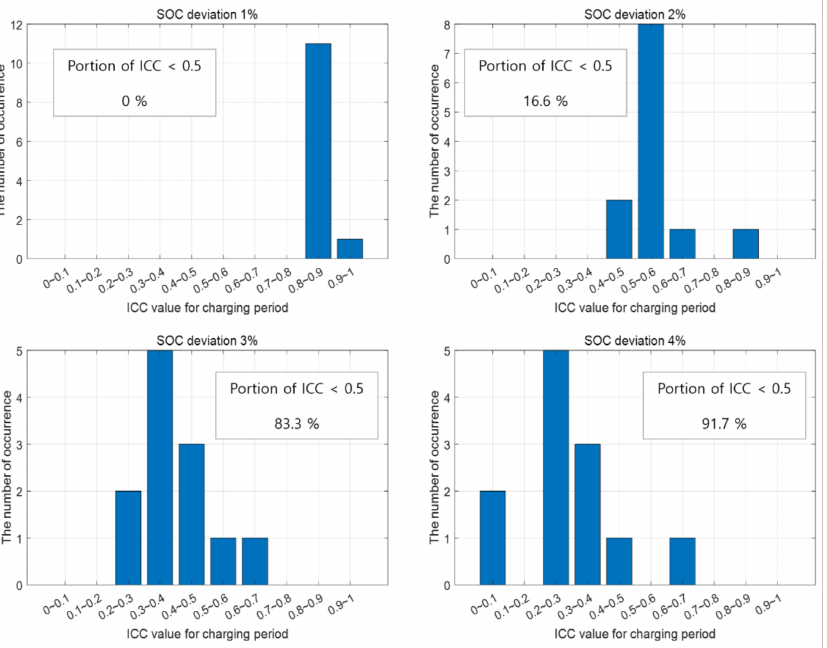
Figure 5. ICC value